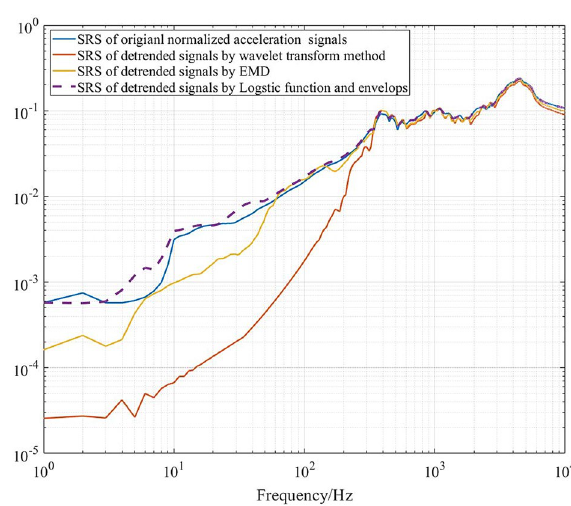
Figure 12. SRS of detrended signals using different